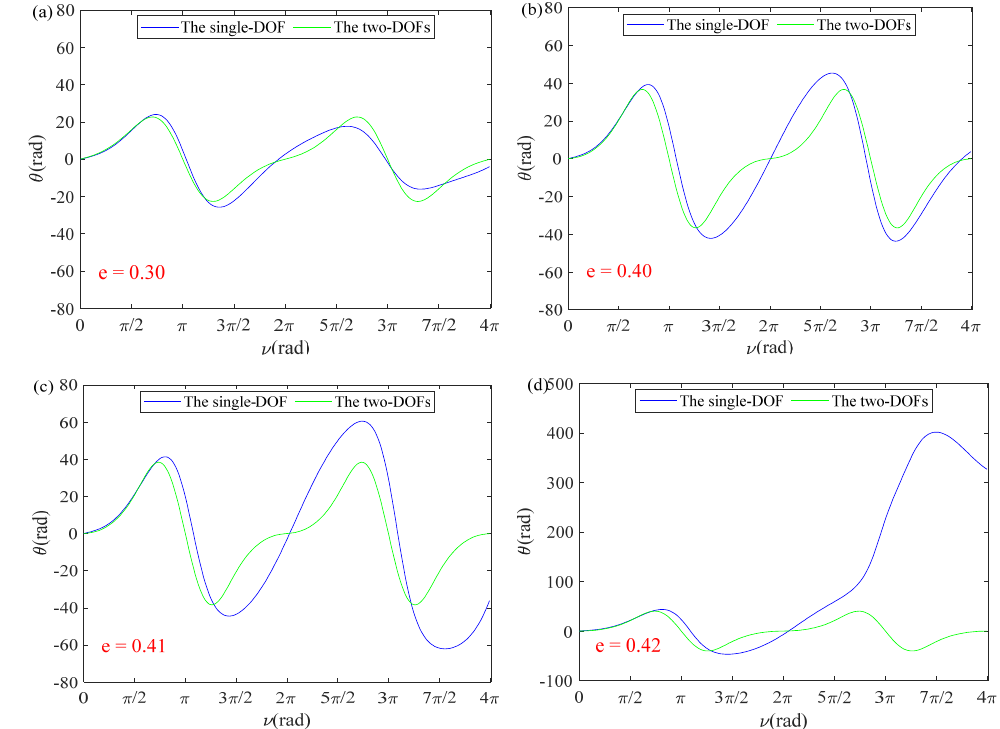
Figure 5. Coupling effects of ϕ : ( a ) e = 0.30; ( b ) e = 0.40; ( c ) e = 0.41; ( d ) e = 0.42.